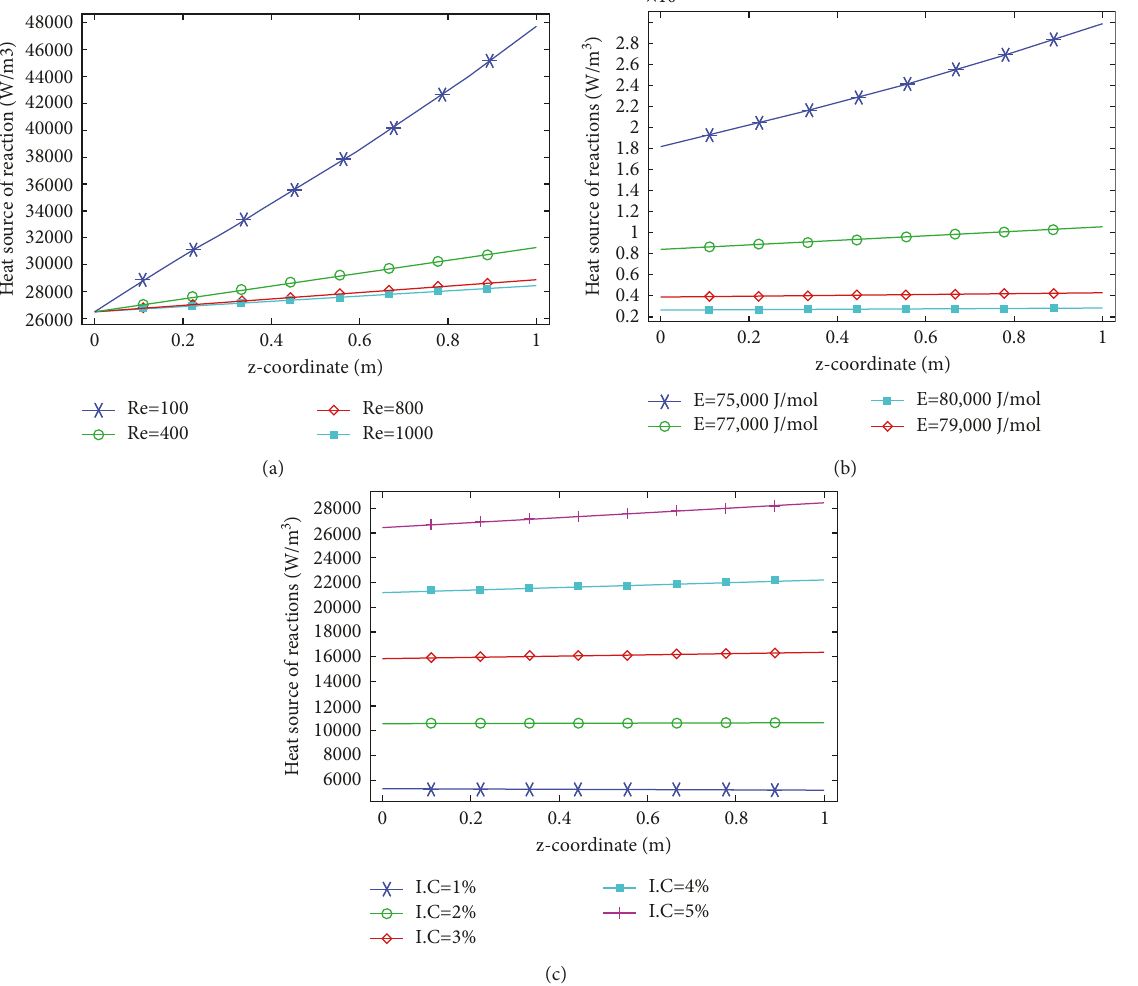
Figure 15: Heat source of reaction: (a) I.C � 5%, E � 80,000J/mol; (b) I.C � 5%, Re � 1000; (c) Re � 1000, E �